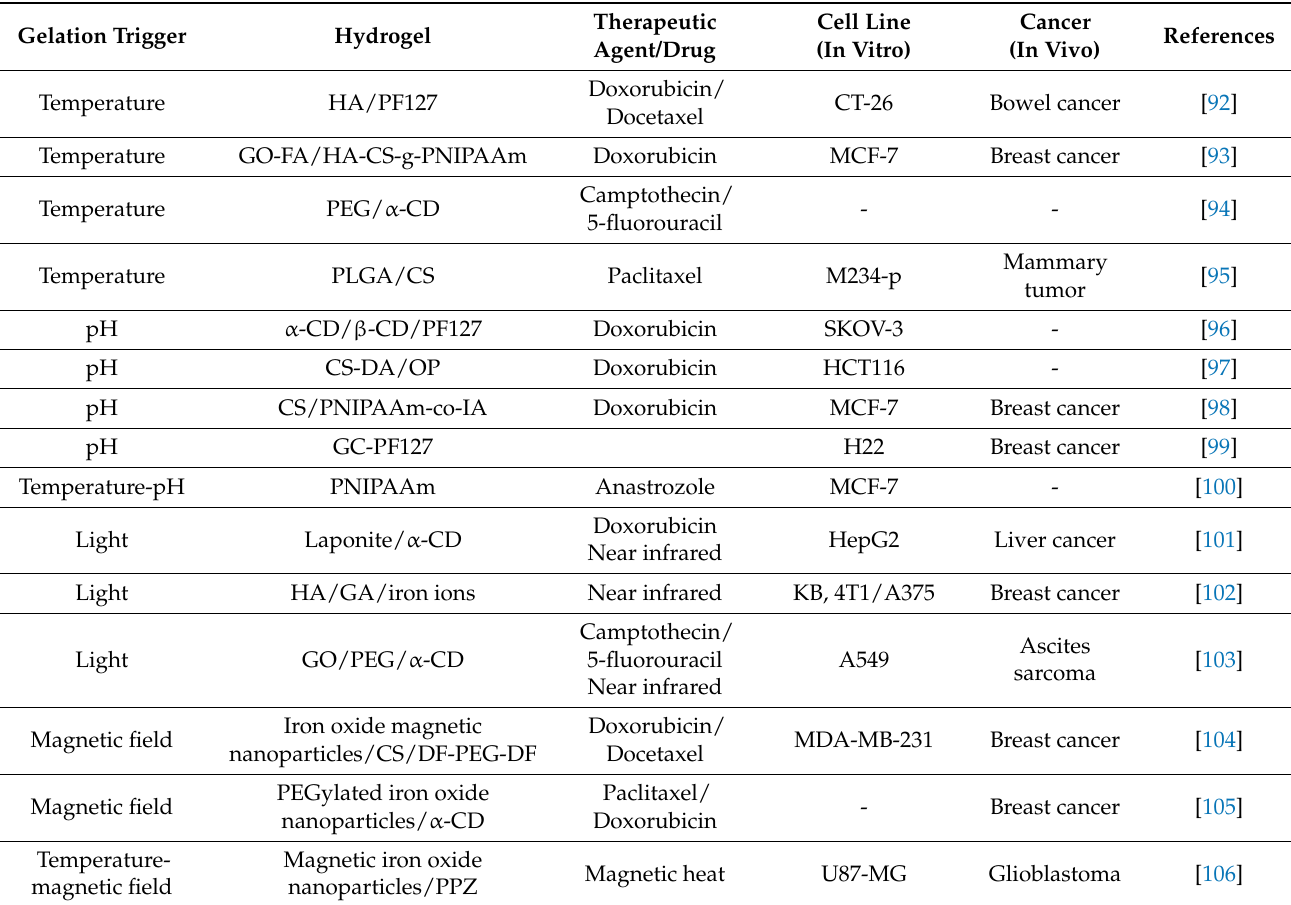
Table 2. Recent research on stimuli-sensitive supramolecular hydrogel systems in cancer